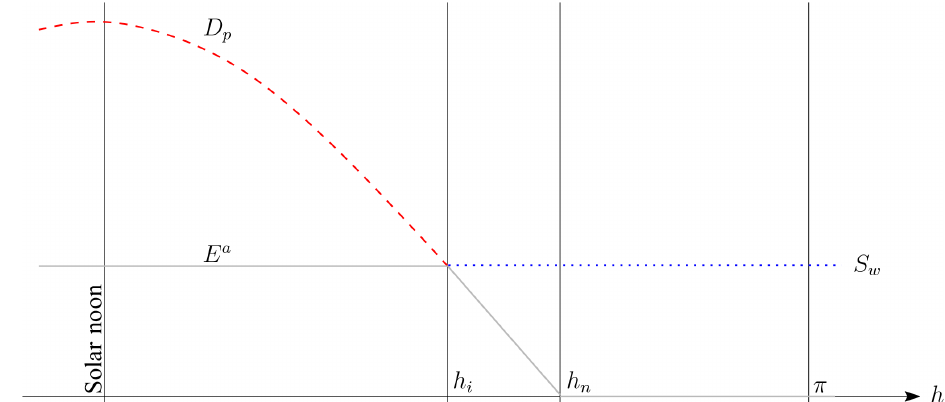
Figure 2. Example of actual evapotranspiration curve between the hours of solar noon (i.e., h = 0) and solar midnight (i.e., h = π ). The evaporative demand, D p (dashed red line), is at a maximum at solar noon and zero at the cross-over hour angle, h n . The evaporative supply, S w (dotted blue line), is constant throughout the day. The point where supply is equal to demand denotes the intersection hour angle, h i . Actual evapotranspiration (solid gray line) is defined as the minimum of S w and D p throughout the